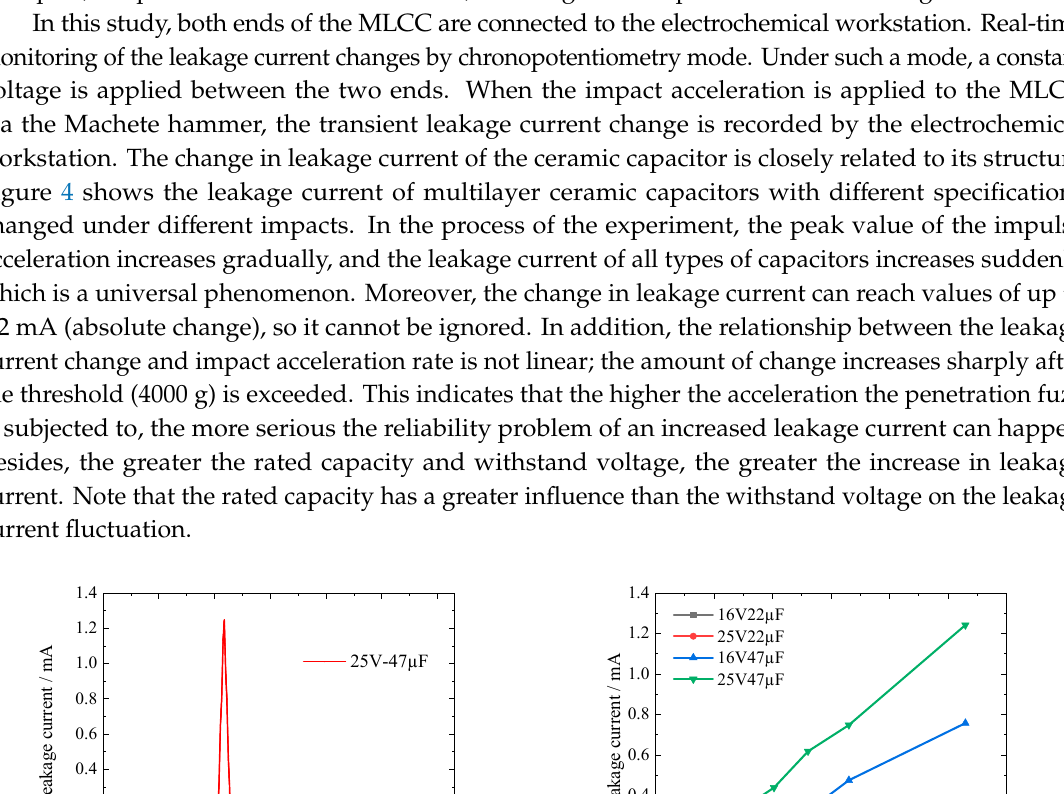
Table 2. Capacity change of the MLCC under a different impact acceleration.